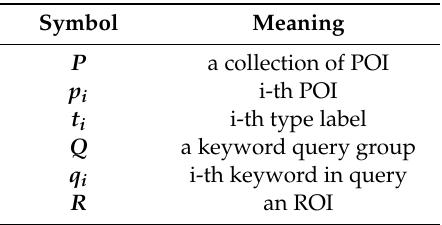
Table 2. Symbols Table 2. Symbols list.